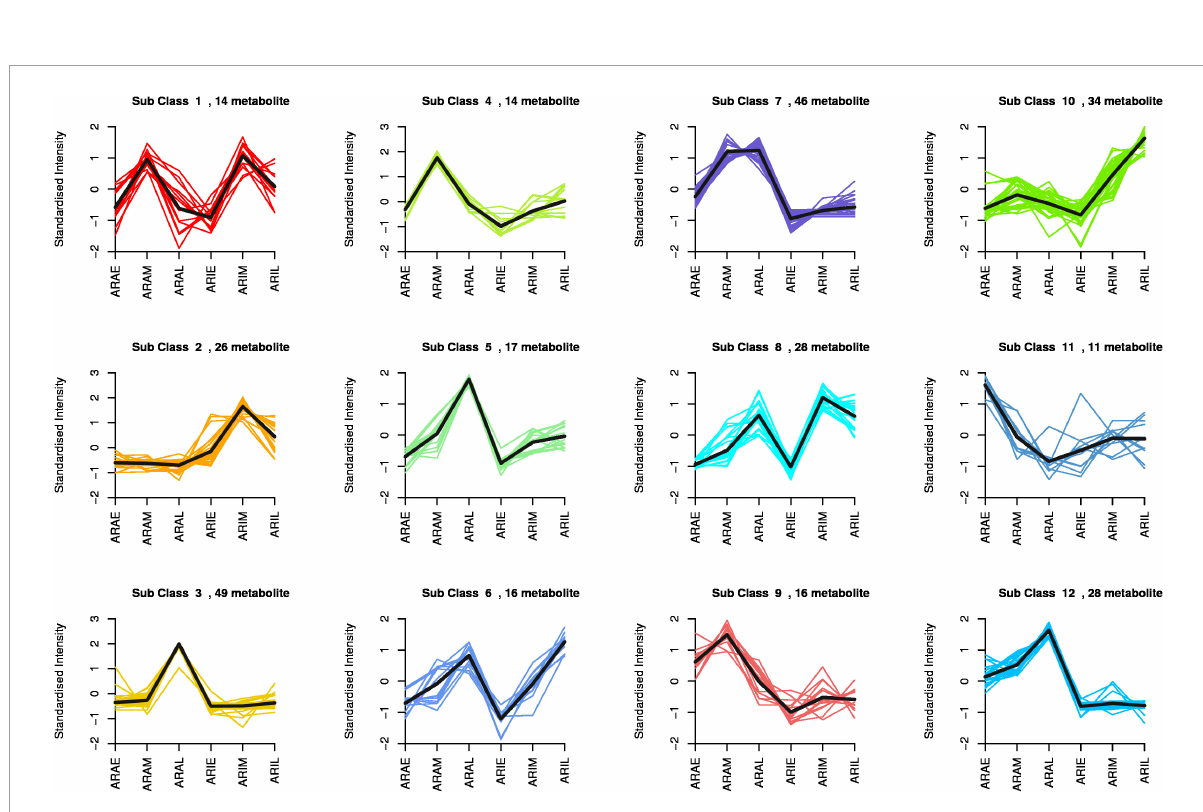
FIGURE5 K-means analysis of differential flavonoid metabolites of A. argyi and A. indica . The X-axis represents the name of the sample, the Y-axis represents the standardized relative content of metabolites, the subclass represents the number of metabolites with the same